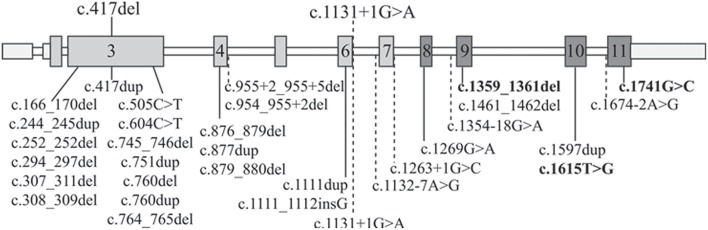
ESCO2 pathogenic alterations. Schematic diagram of full-length ESCO2 gene: exons are depicted as boxes while introns as thin bars. Exons encoding the acetyltransferase domain are in dark gray. The two mutations carried by the patients herein described are over the gene schematic while all the 32 known pathogenic alterations found in RBS-SC Phocomelia patients are listed below. The only 3 “non-inactivating” mutations (2 missense mutations and a three-nucleotide deletion) are bolded. The horizontal dashed lines indicate intronic mutations leading to miss-splicing.